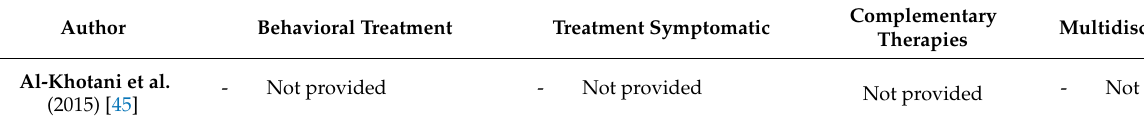
Table 4. Summary of the pediatric chronic pain